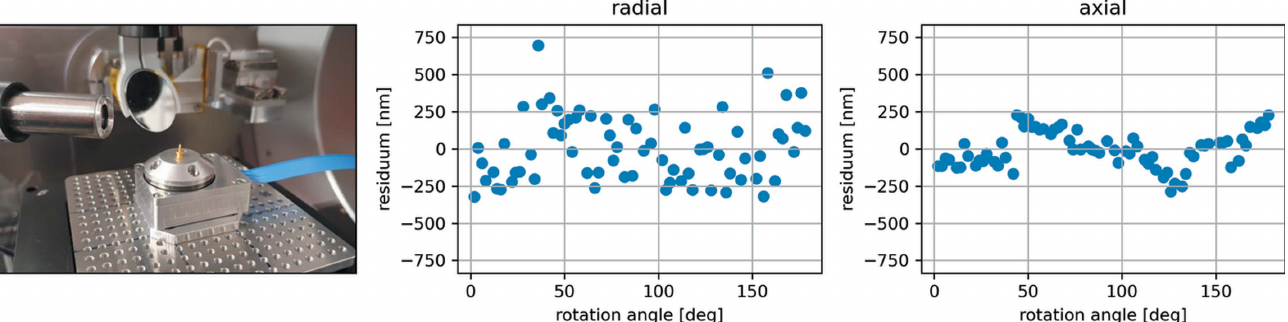
Figure 10 (Left) A piezo rotation stage mounted on top of the piezo scanner breadboard with a pin holding the sample for a nano-tomography experiment. (Center) Estimated position error in the radial and (right) axial directions. Both measurements show the resulting sum of all contributions: that is, the position errors from every stage in the stacks, as well as long-term drifts in the whole